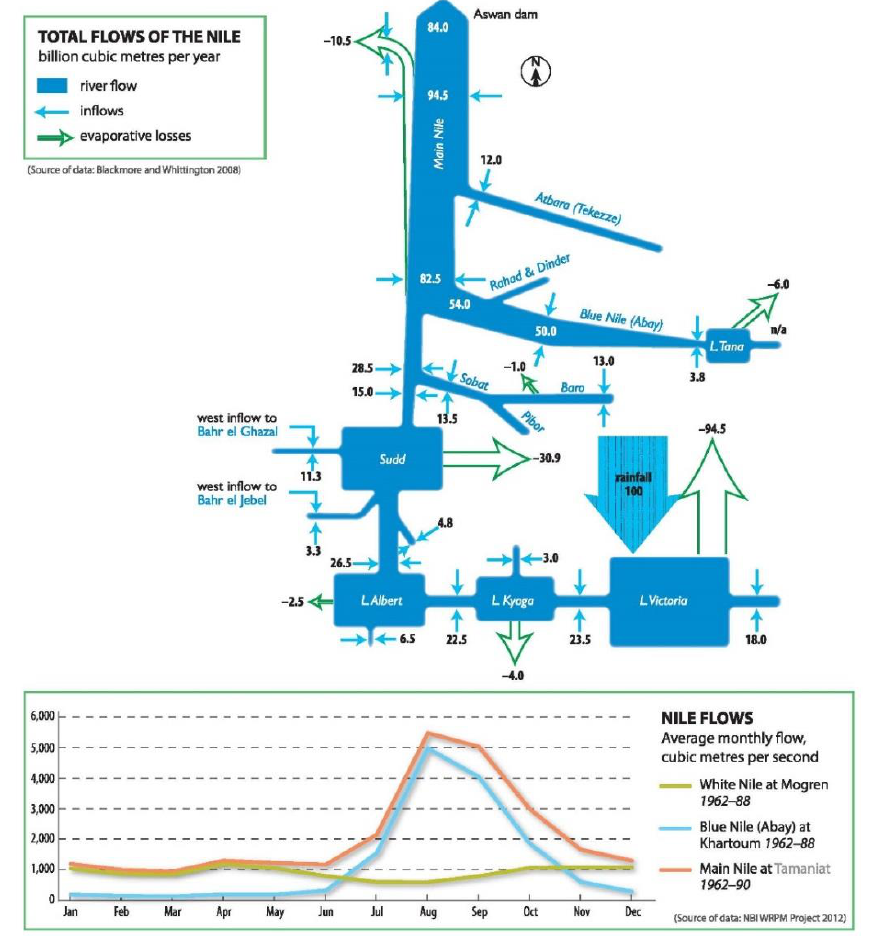
Figure 2 The total flows of the Nile in billion cubic meters per year. The years represented are from 1962 to 1990. The data represented includes river flows, inflows, and evaporative losses. Source (NBI,